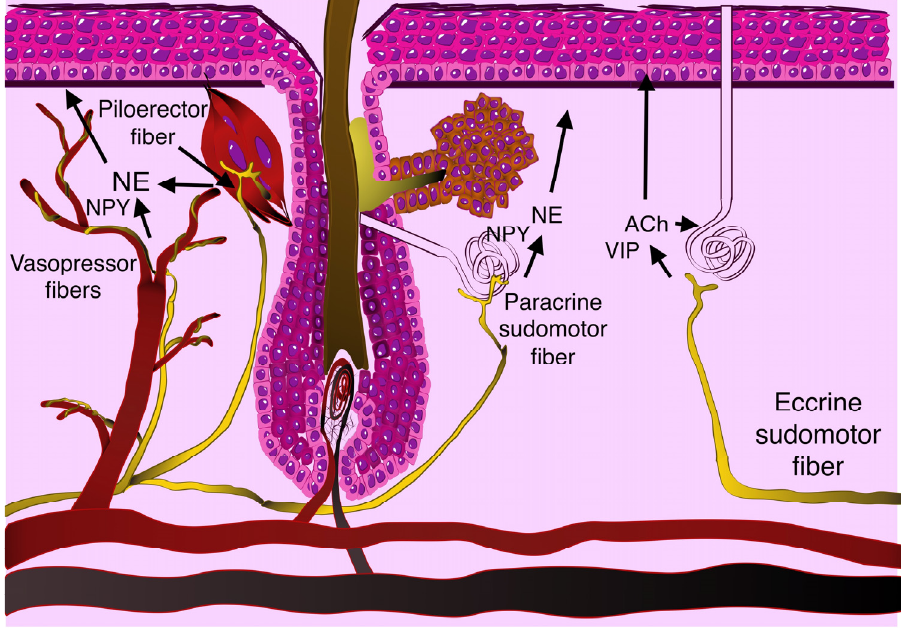
Figure 1. Normal autonomic skin innervation .